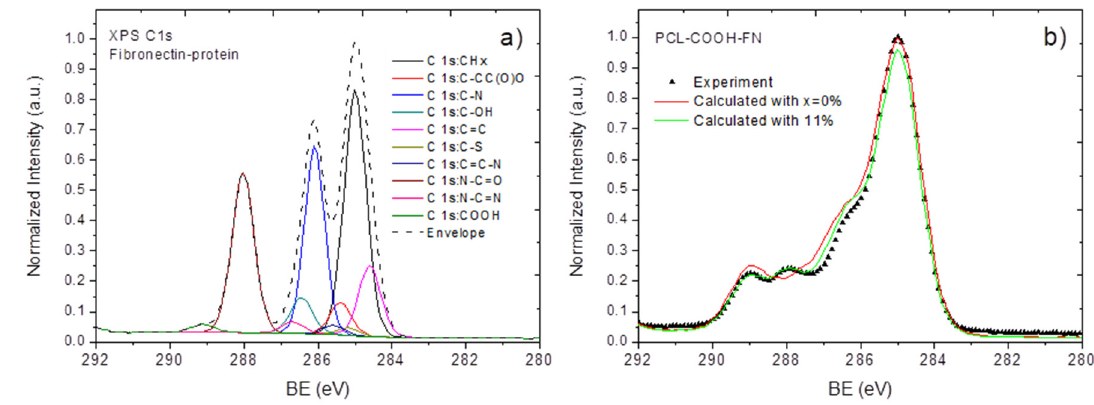
Figure 7. A comparison of the XPS C1s signals of PCL-ANG ( a ) and PCL-COOH-ANG ( b ), which were measured experimentally and modeled using Equation (1).